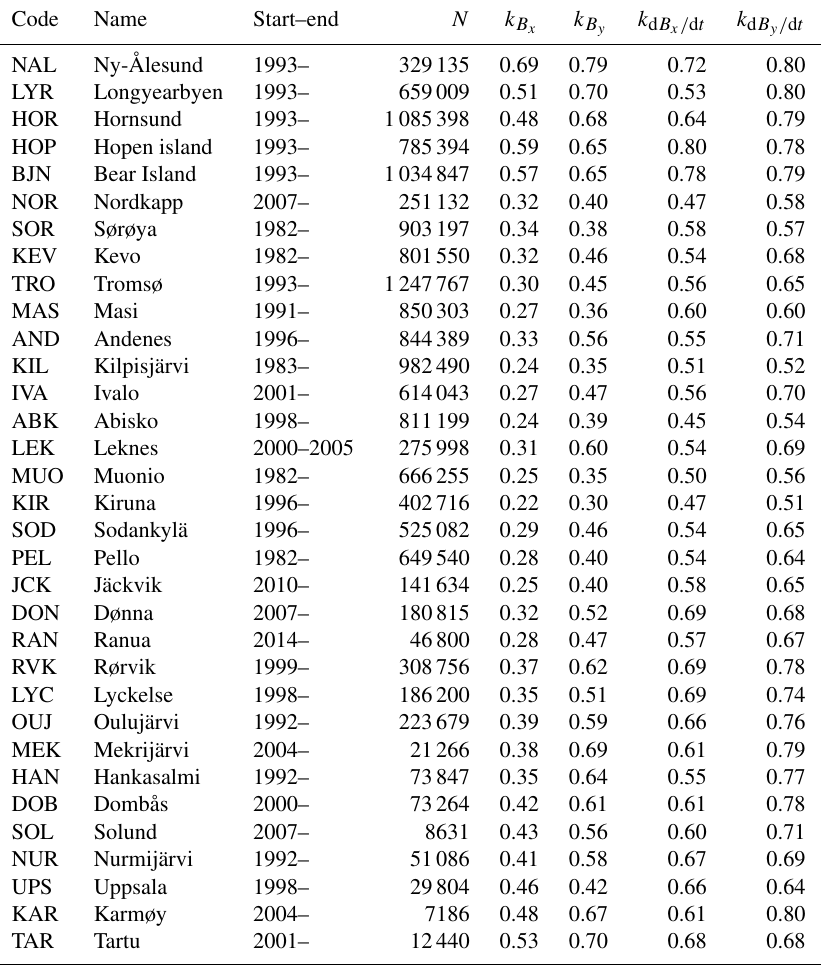
Table 1. IMAGE station, start and possible end year of operation, number of 10s data points N with d H/ d t > 1nTs − 1 in 1994–2018, k from B x, telluric = k · B x + const . for B x , B y , d B x / d t , and d B y / d t